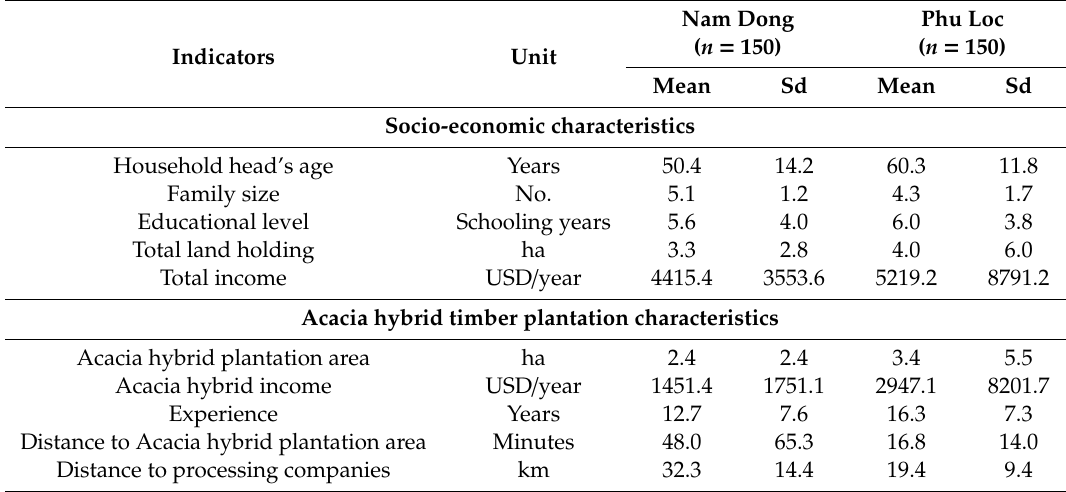
Table 2. Characteristics of small-scale Acacia hybrid timber producers in Nam Dong and Phu Loc district.